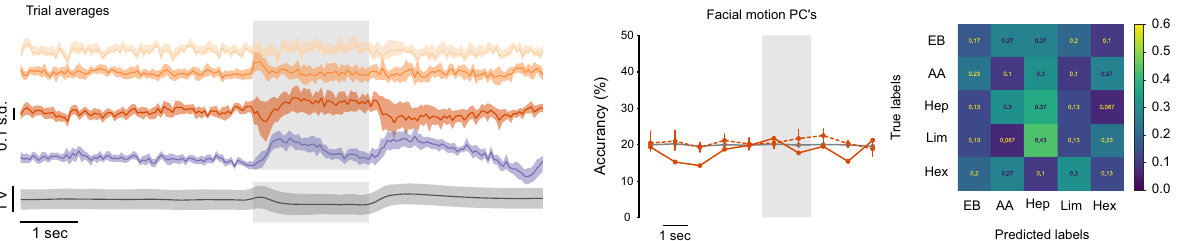
Fig. 7 Olfactory information in the barrel cortex is not explained by facial behavior. a Schematic of the multi-odor protocol (left) and max projection of a sample fi eld of view for two-photon imaging of four simultaneous planes Scale bar 200 µ m. (right). Facial behavior was monitored with a video camera at 20 Hz. Scale bar 2 mm. b Mean deconvolved calcium signal for fi ve odors and fi ve example barrel cortex neurons. Shading indicates odor presentation. Error bars indicate 95% con fi dence intervals for the mean traces. c Left: classi fi er accuracy for the 5 odor identities. Purple line: classi fi cation with the full dataset (13,168 neurons). Dashed line: mean accuracy of single session classi fi cations. Gray line: chance level estimated on shuf fl ed data. Right: confusion matrix for the full dataset classi fi er at the second time bin of stimulus presentation. EB ethyl butyrate, AA amyl acetate, Hep heptanal, Lim limonene, Hex hexanone. d Accuracy of a classi fi er discriminating amyl acetate from ethyl butyrate based on barrel cortex activity (full dataset) and categorization scores of the same classi fi er for four mixtures of the two odors. The classi fi er was not trained on mixtures. c , d ** P < 0.01, *** P < 0.001 (two-sided P values, based on the distribution of 1000 shuf fl es. Minimum P value: 0.001, no correction for multiple testing). e Spectrum of the fraction of explained variance for the principal components (PCs) of neuronal activity (mean across 11 sessions). f Loadings of three facial behavior PCs and of the fi rst neuronal activity PCs for a short time sample in an example recording session. g Average loadings for the same PCs as in f , across all odor presentations of the recording session. h Left: decoding accuracy of odor identity using the fi rst 500 facial behavior PCs. Chance level performance is obtained whether the classi fi cation is done in single sessions (dashed line, n = 12 sessions) or after pooling PCs of all sessions (plain line). Right: confusion matrix of the pooled-session classi fi er. Error bars and bands indicate 95% con fi dence intervals for the mean throughout the fi gure. All tests are